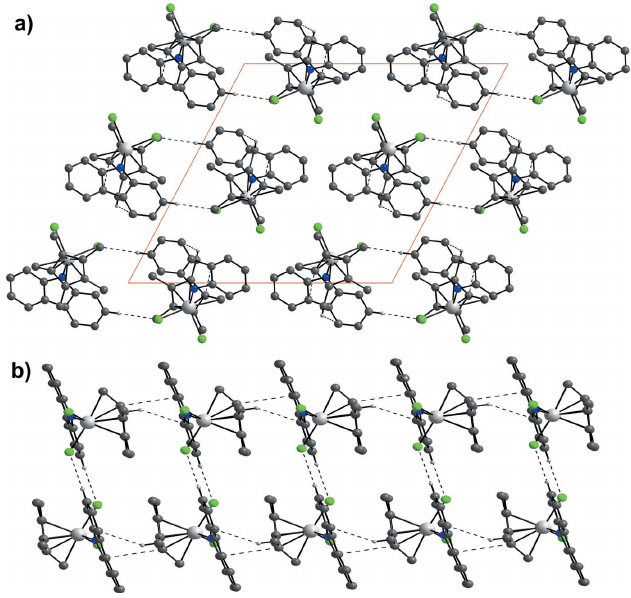
Figure 2 ( a ) Schematic representation of key structural factors characterizing a pentafulvene complex. ( b ) Schematic drawing of the pentafulvene ligand above the central tantalum atom. C—C bond lengths of the pentafulvene ligand are given in A˚ .